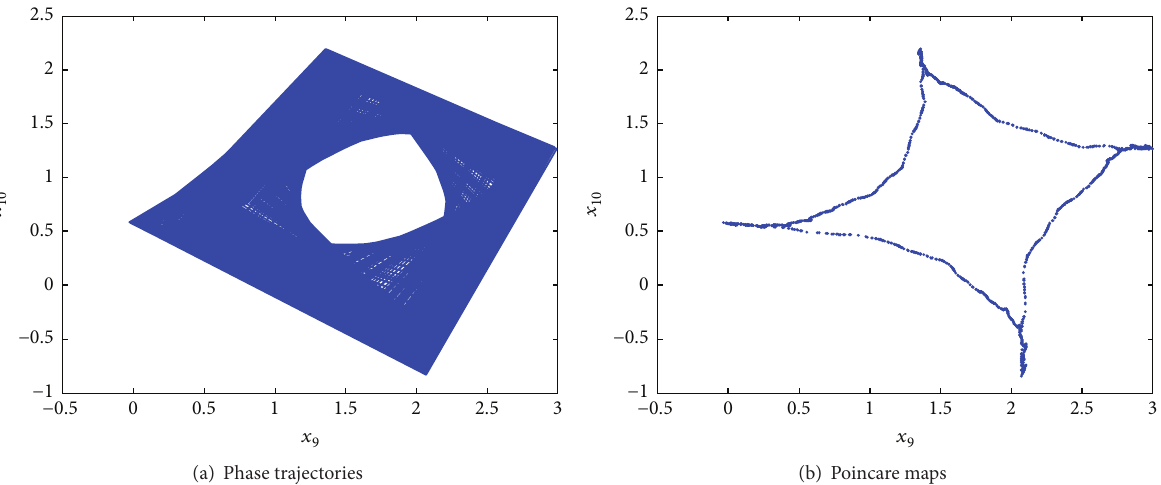
Figure 8: 𝜔 = 240 without random perturbation.